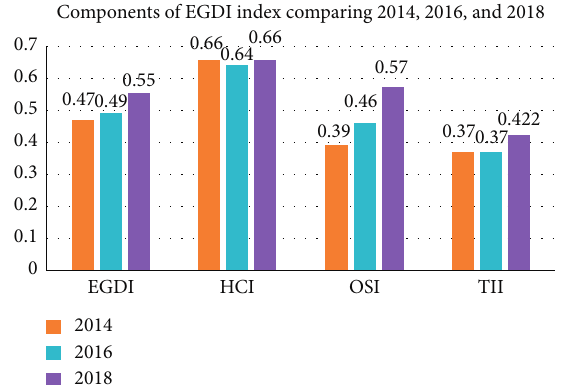
Figure 2: Breakdown of EGDI indices comparing data from 2014, 2016, and